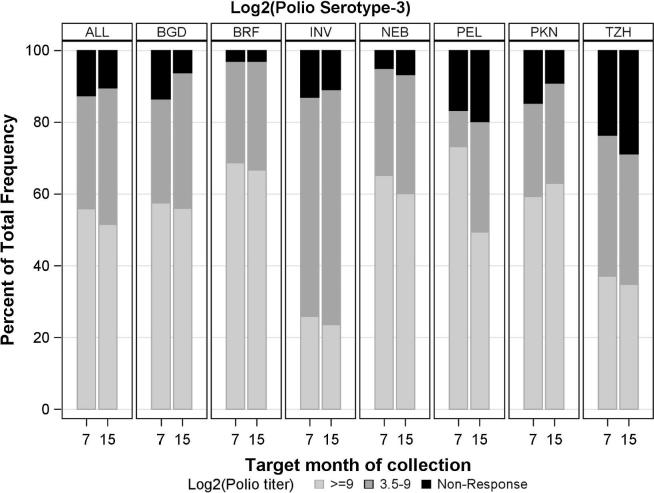
Poliovirus serotype 3 neutralization titer distributions by site and scheduled month of blood collection. Site locations; Dhaka, Bangladesh (BGD), Foratleza, Brazil (BRF); Vellore, India (INV); Bhaktapur, Nepal (NEB); Loreto, Peru (PEL); Naushero Feroze, Pakistan (PKN); Haydom, Tanzania (TZH).